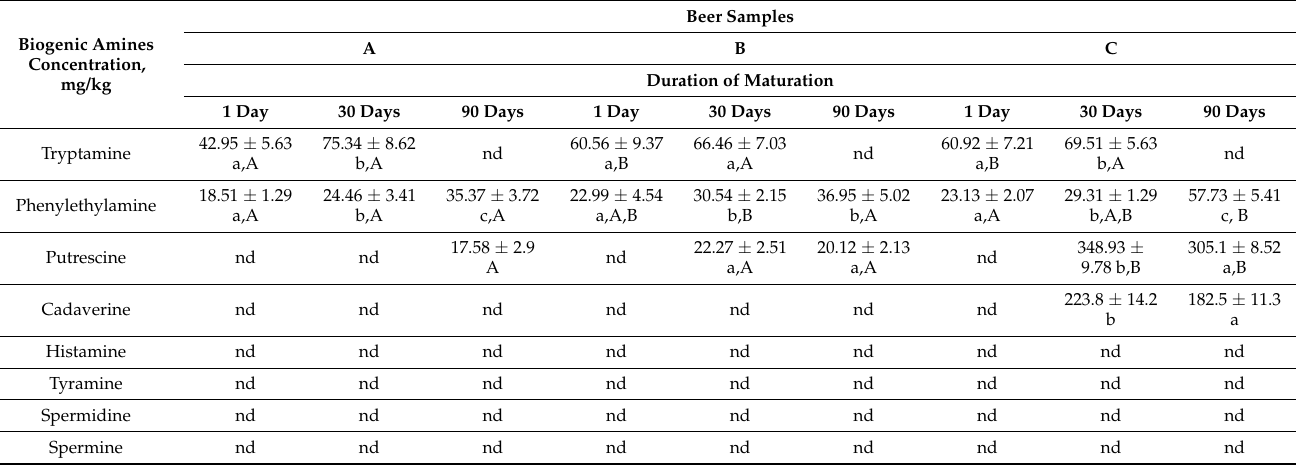
Table 6. Biogenic amines concentration of the beer samples (A—beer fermented with Saccharomyces cerevisiae var. diastaticus ; B—beer fermented with Saccharomyces cerevisiae var. bayanus ; C—beer fermented with Brettanomyces claussenii